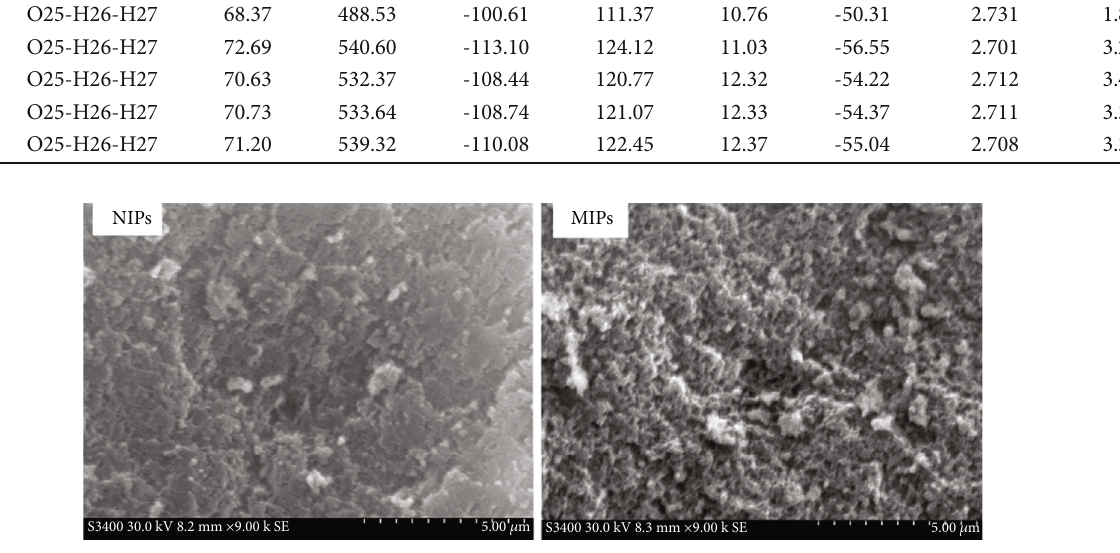
Figure 3: The SEM photograph of MIPs and